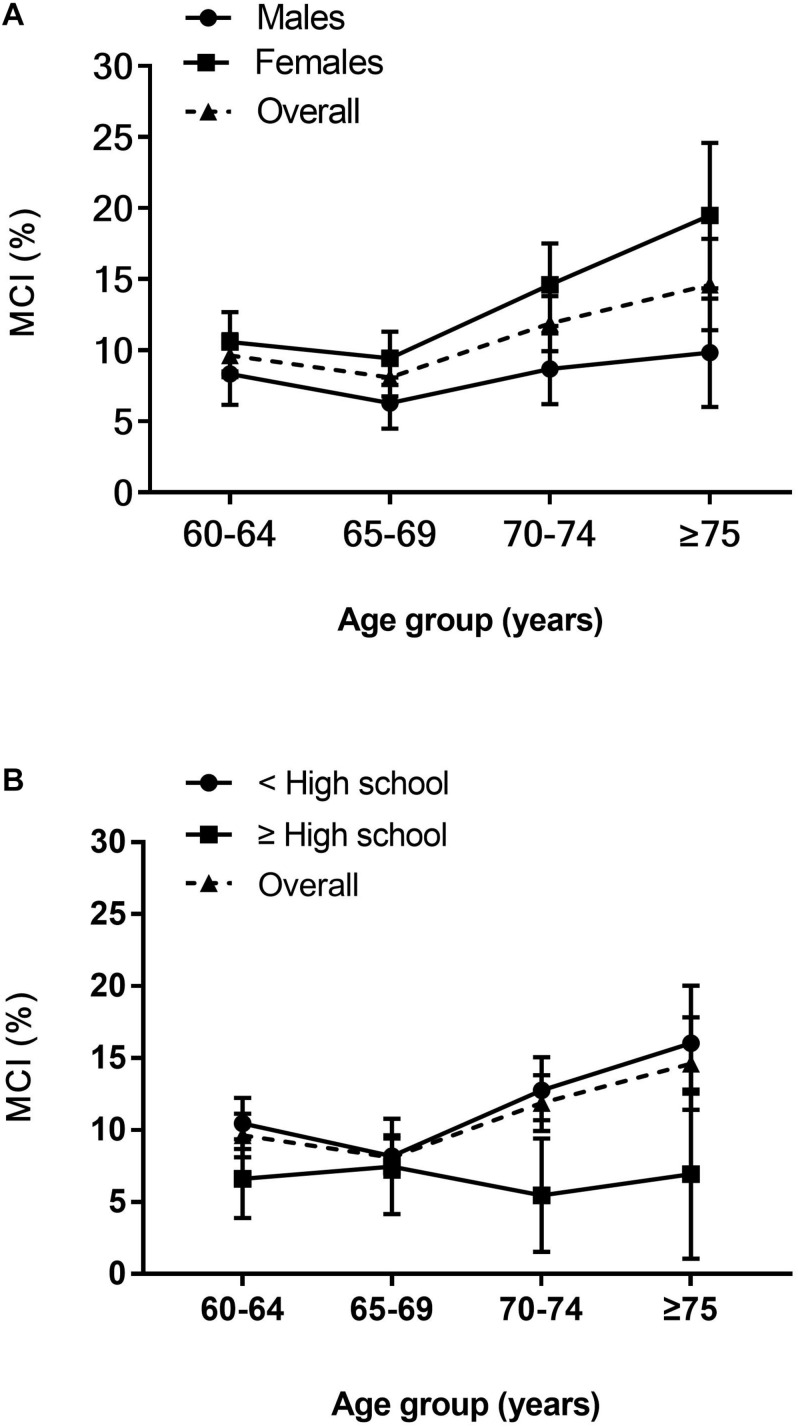
Age-specific prevalence of MCI. (A) Age and sex-specific prevalence of MCI. (B) Age and education-specific prevalence of MCI. Prevalence point estimates are presented with (vertical) 95% CIs.